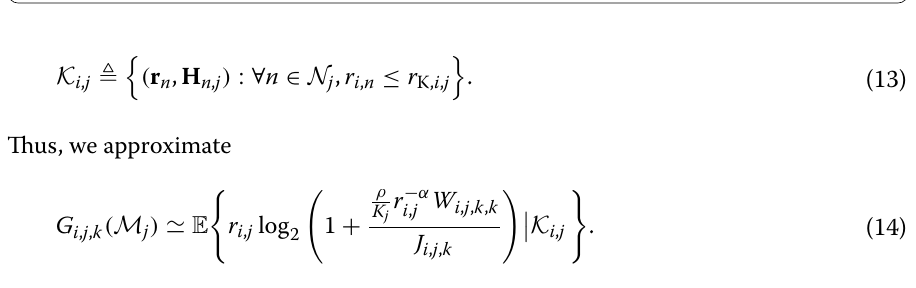
Fig. 1 Local neighborhood of the probe transmitter: each dot represents a node in the network. The red triangle is the probe transmitting node and the green star is the tested relay (node i in this example). The red dashed circle represents the routing zone with radius r RZ centered at the probe transmitter. The distance between the probe transmitter and the tested relay is r i , j . The known zone (KZ) of tested relay i is marked by the small blue dotted circle centered at the tested relay with radius r K, i , j (12). In this case, the KZ contains a single undesired node; thus, N K, i , j =